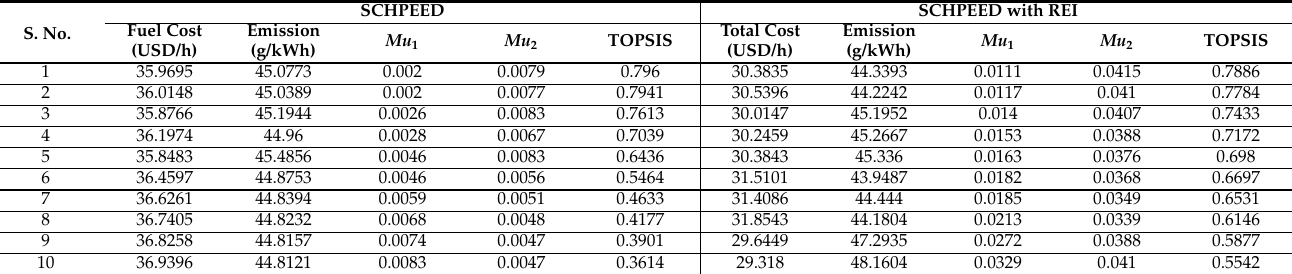
Table 7. Top ten Pareto optimal solution for SCHPEED.